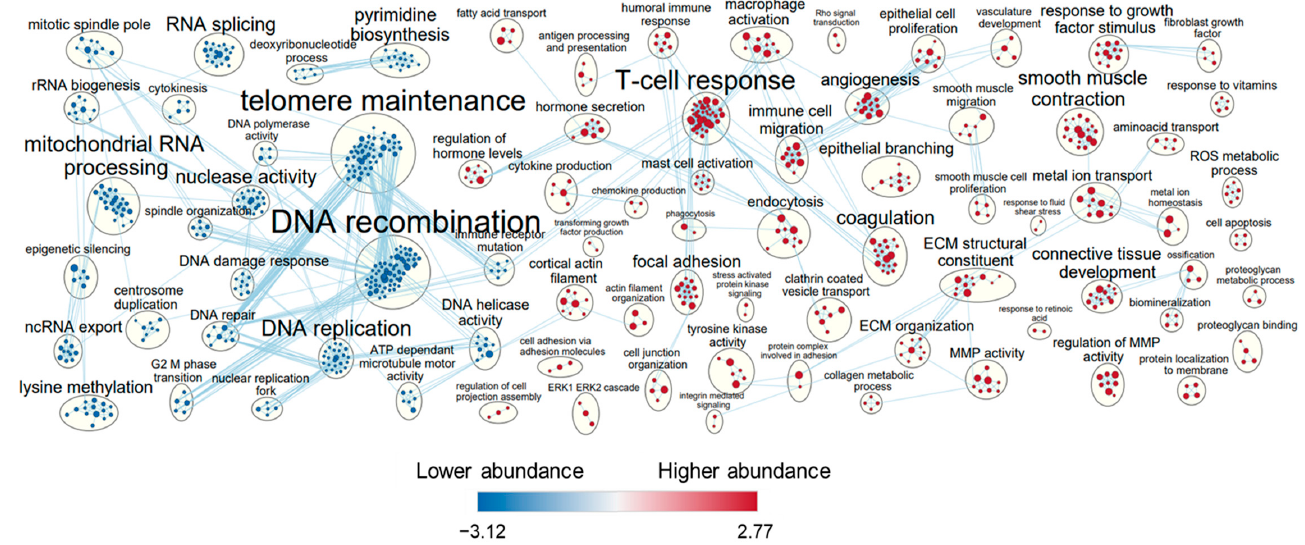
Figure 3. Gene set enrichment analysis (GSEA) of differentially expressed genes (DEGs) in mesothelial cells. Of the 10,624 genes shared by HPMC and MeT-5A, significantly different regulation (FDR Q-value < 0.05) of gene sets as identified by GSEA are shown. Nodes of GO terms of more abundant gene sets are represented in red, and of less abundant gene sets in blue. Node size reflects the gene set size and letter size indicates the size of the summary term. Genes shared by gene sets are reflected by connecting lines.